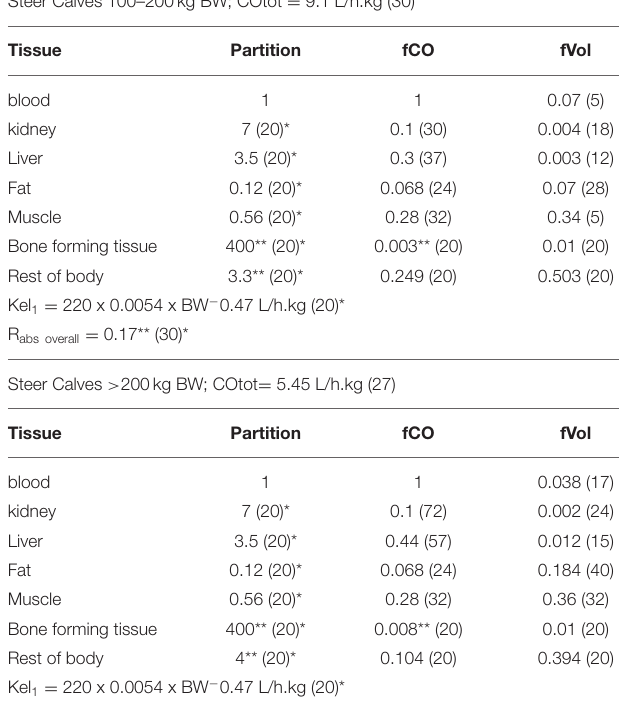
TABLE 6 | Final sets of parameter values [mean (CV%)] for 100–200kg BW and > 200kg BW steers from literature or after